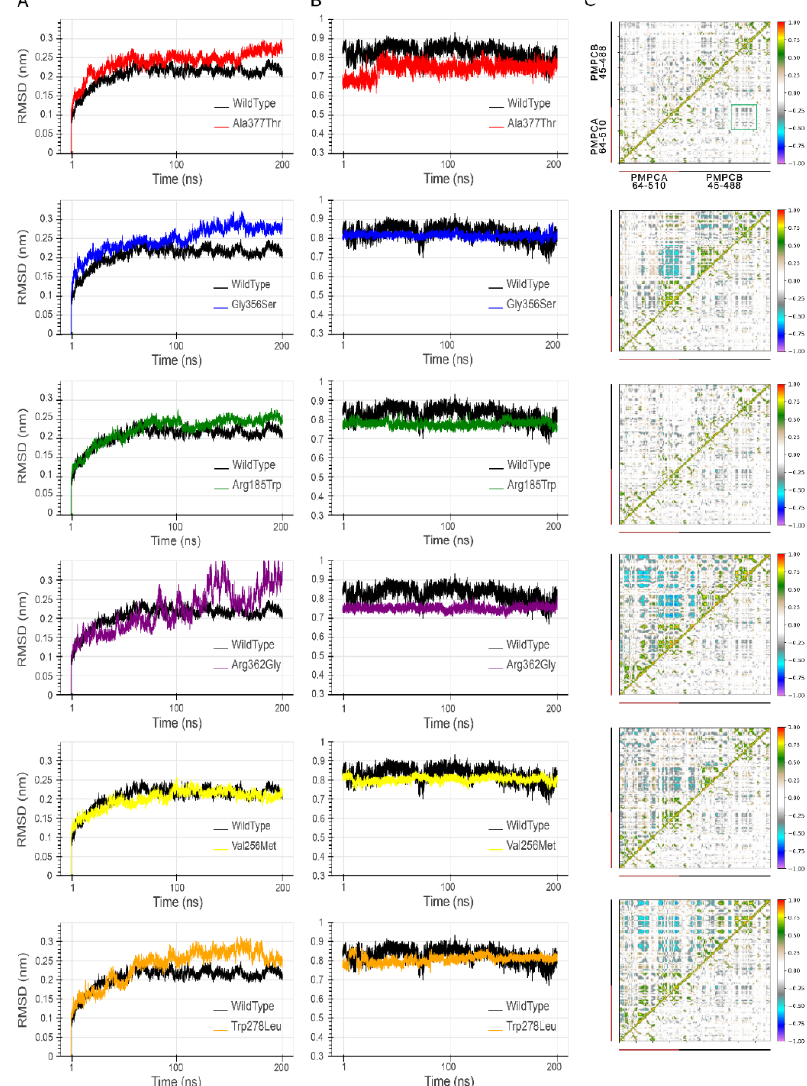
Figure 4. Root-mean-square deviation (RMSD) profiles of the C α atoms of the wild type (wt) (black) and all mutant systems for the whole heterodimer ( A ) and the glycine-rich loop ( B ). ( C ) Dynamic cross-correlation maps (DCCMs) of wt (lower triangular of each matrix) and all PMPCA mutants (upper triangular). Perfect correlations are highlighted in red (direct) or violet (inverse). Green box highlights the wt anticorrelated movements between residues 300 and 400.